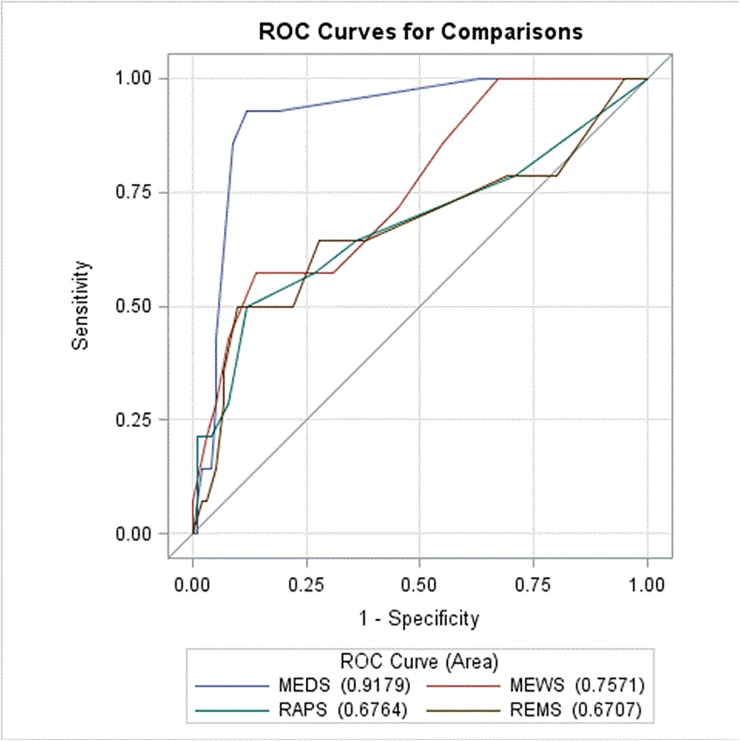
Receiver operating curves for predicting death according the RAPS, MEWS, REMS, and MEDS scoring systems.